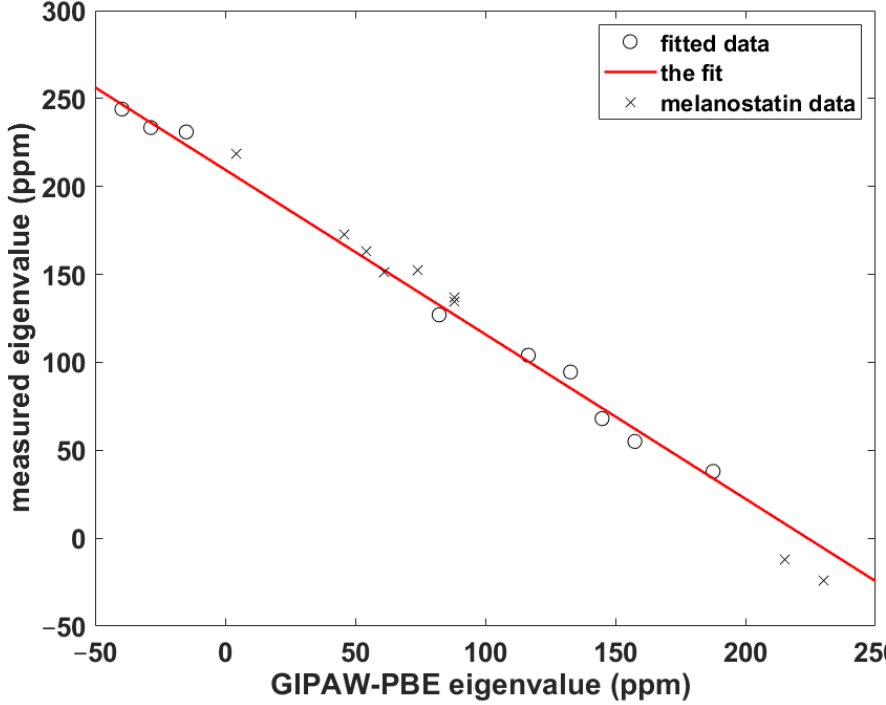
Figure 5. The linear relationship between the 15 N amid δ ii and σ ii data described in the text.